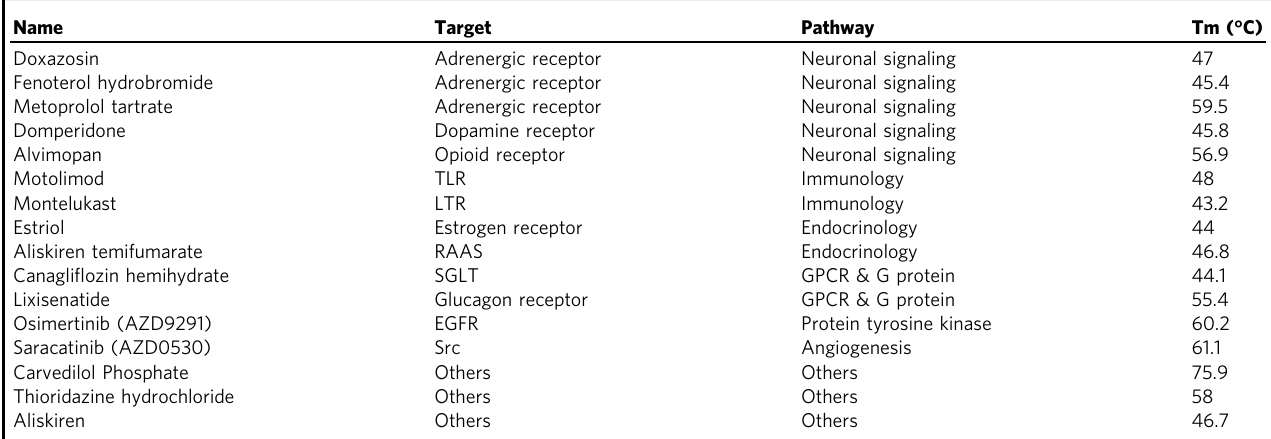
Table 2 Drugs changed the thermal stability of Mtb EF-Tu.